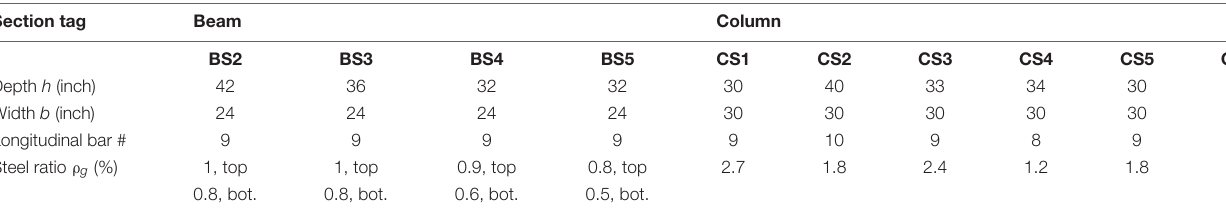
TABLE 2 | Column and beam dimension and reinforcement properties (1 inch = 25.4 mm, bot. = bottom). Section tag